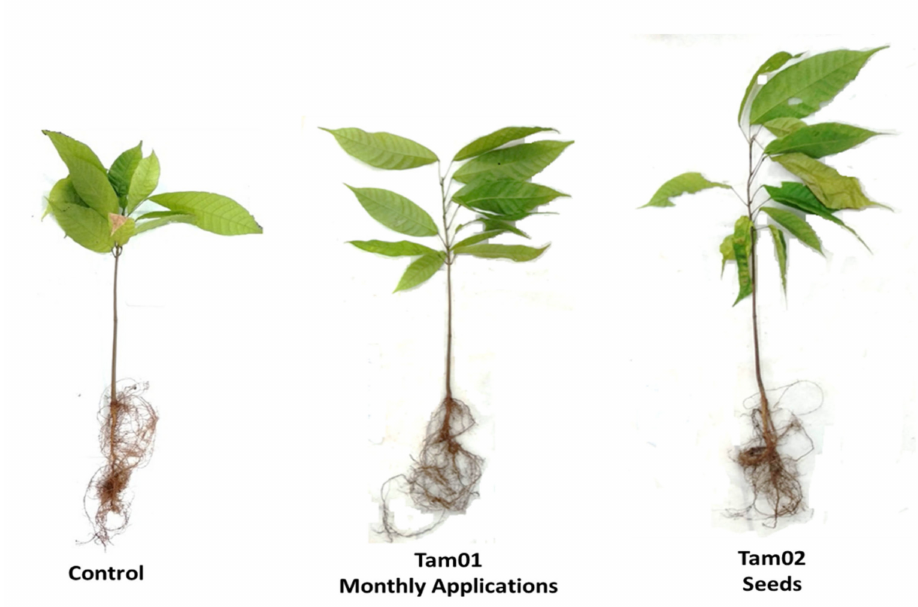
Figure 2. Cocoa seedlings with and without application of Trichoderma asperellum , six months after